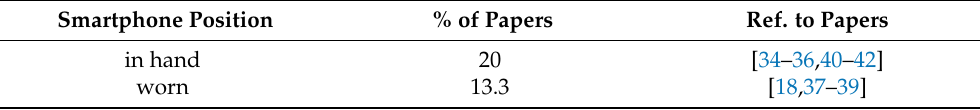
Table 4. How the smartphone is held by the users. Not all systems have been implemented on a